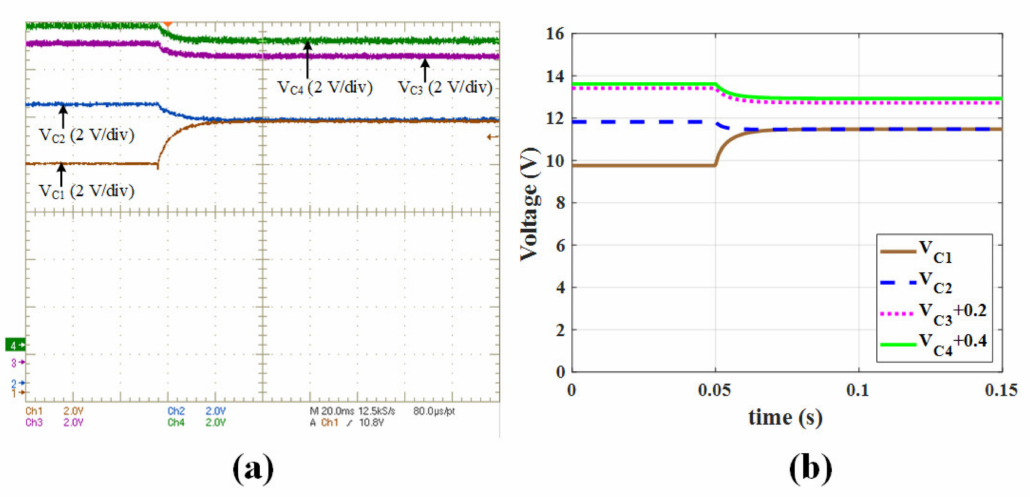
Figure 14. Voltage changes of the boost converters output capacitors in closed-loop when P 1 is changed from 63 to 100 W, and P 2 is set to 100 W: ( a ) Experimental results; ( b ) Simulation results of the average